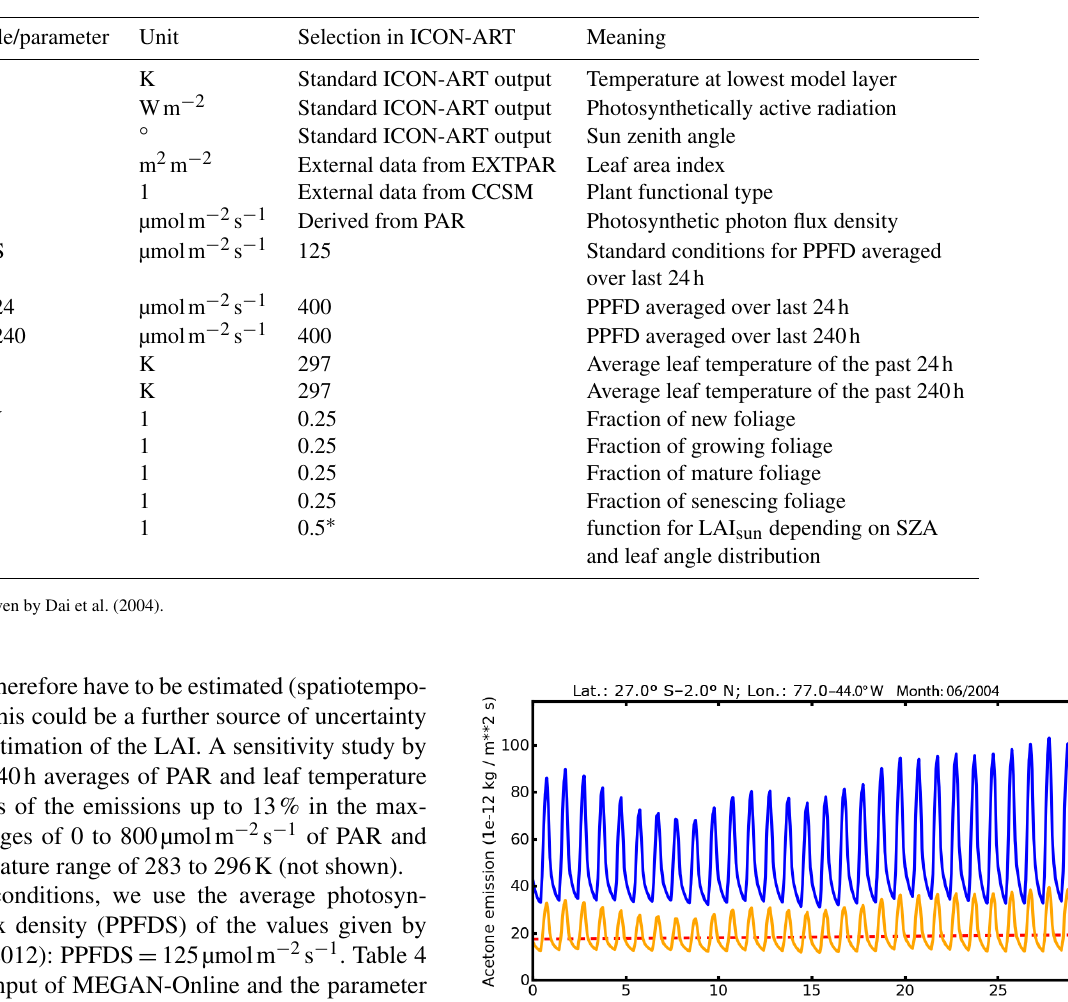
Table 4. Parameters for MEGAN-Online used for this study. Time-dependent parameters are written in italic letters. Variable/parameter Unit Selection in ICON-ART Meaning T K Standard ICON-ART output Temperature at lowest model layer Wm − 2 Standard ICON-ART output Photosynthetically active radiation ◦ Standard ICON-ART output Sun zenith angle External data from EXTPAR Leaf area index External data from CCSM Plant functional type Photosynthetic photon flux density Standard conditions for PPFD averaged